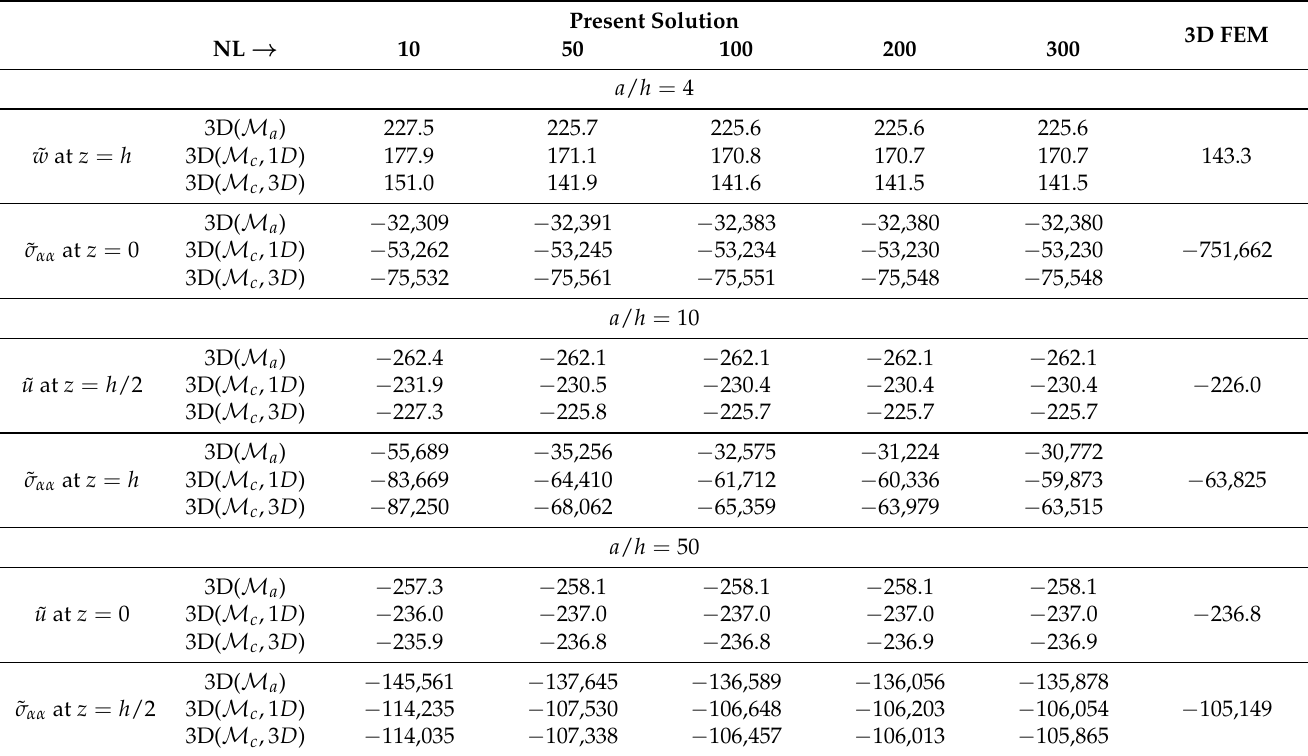
Table 2. Second assessment. One-layered FGM square plate ( a / b = 1), featuring different thickness ratios. The geometry, materials, and FGM power law are the same as the first assessment. The thermal load is substituted by an external moisture content acting on the top ( M t = 1.0%) and bottom ( M b = 0.5%) surfaces; m = n = 1. The reference solution is the 3D FE model, already validated in the previous assessment. The results of the present solution are obtained with N = 3 and for a varying number of mathematical layers NL. Present